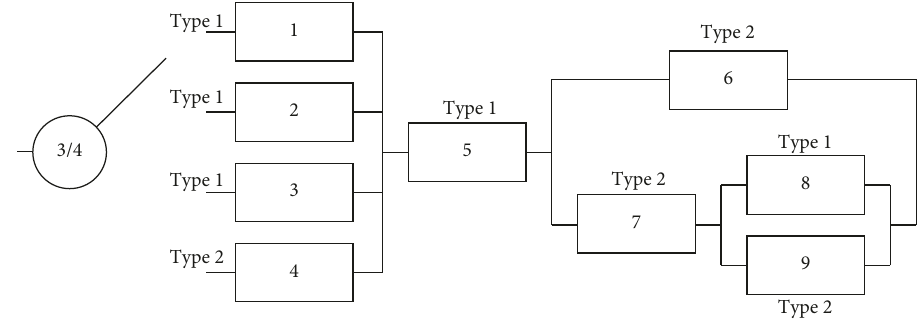
Figure 10: System with 9 components of 2 types. Table 6: Parameters used in optimization (Example 1).